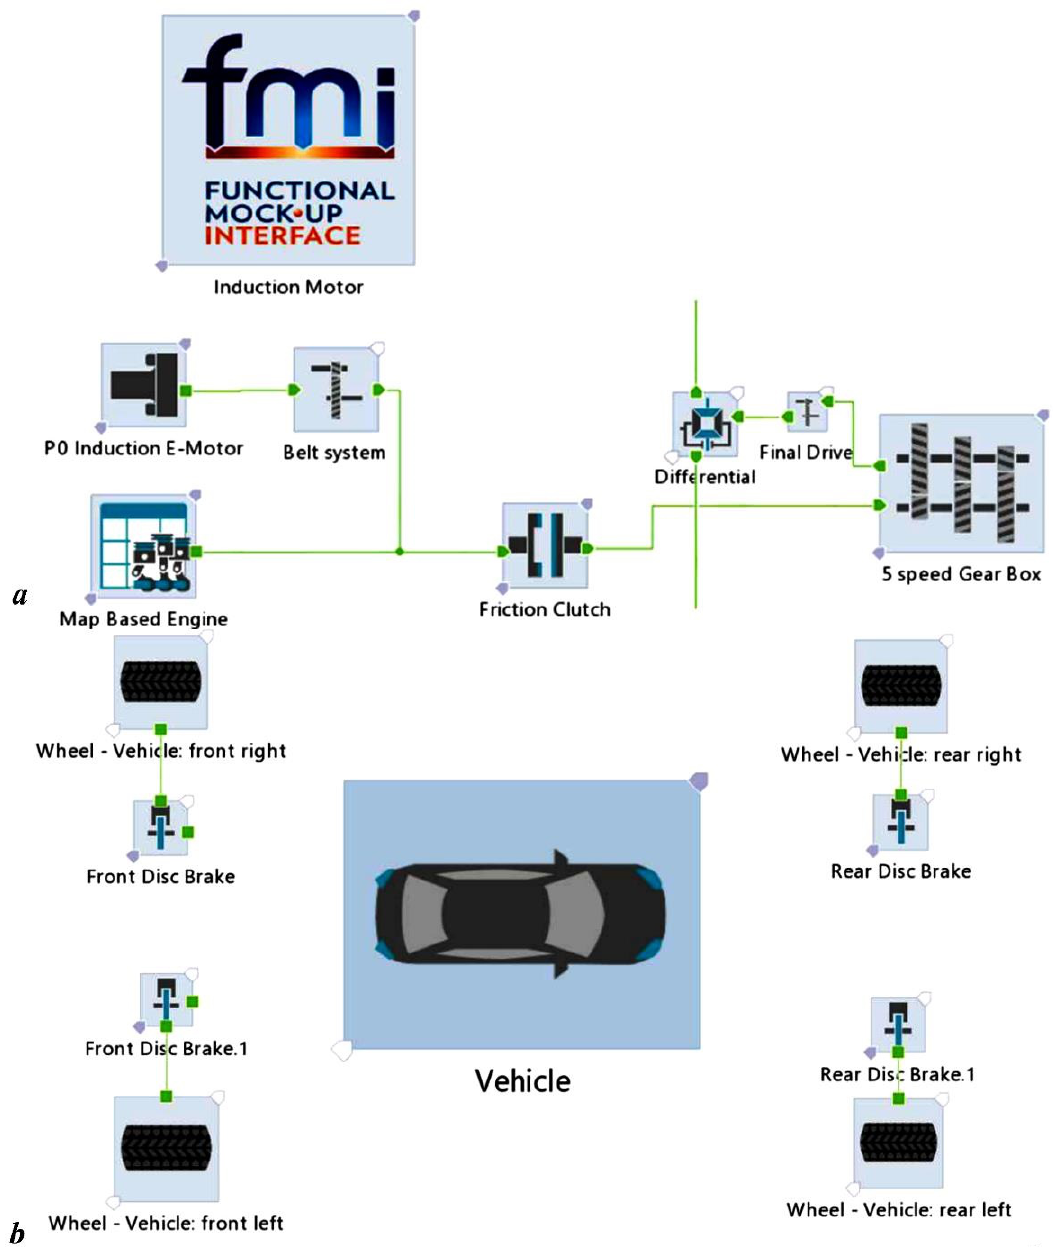
Figure 12. Principal scheme of CRUISE TM M integration of BSG drive FMU model within P0 mild hybrid power train model ( a ), and overall road vehicle model ( b ) [10].